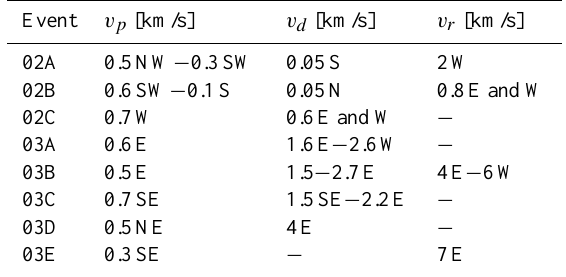
Table 3. Comparison of the different velocities observed. v p is plasma flow velocity measured by the EISCAT radar, v d is the drift velocity of black structures, v r is the velocity of small-scale pertur- bations or ripples on the borders of the black structures. NW stands for northwest, etc.